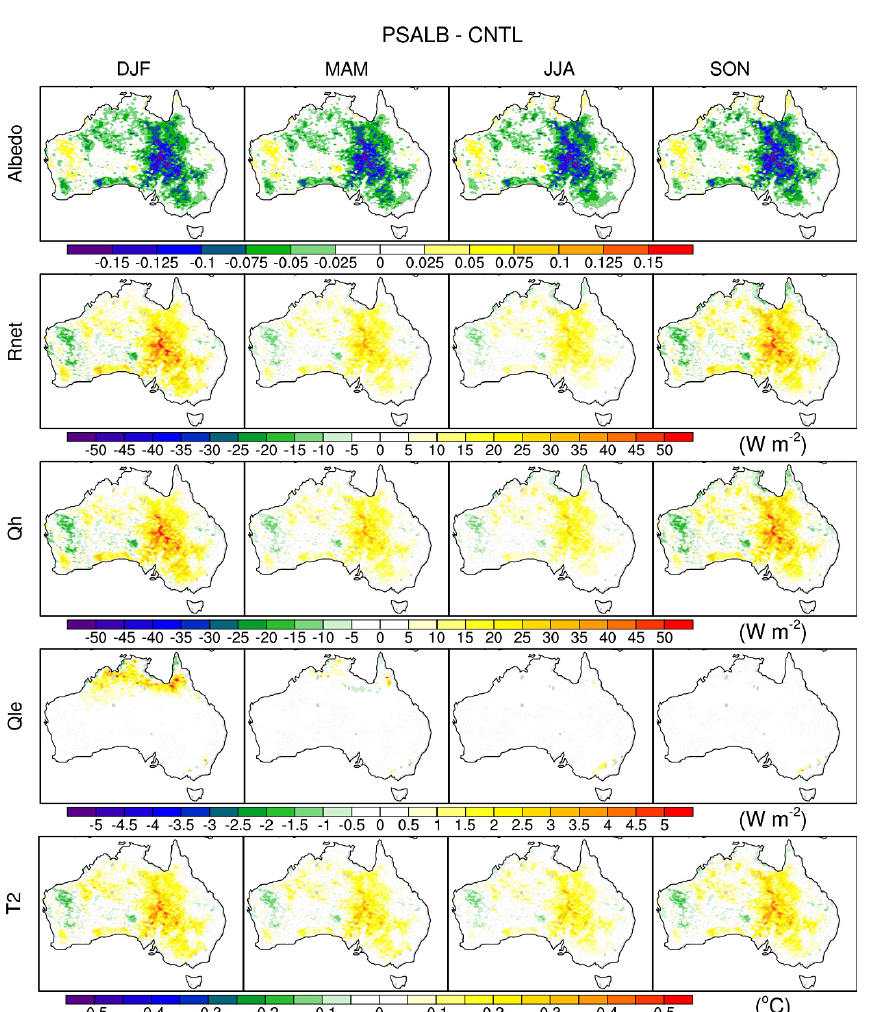
Figure 10. Seasonal differences in albedo, net radiation (Rnet), sensible heat (Qh), latent heat (Qle) flux, and screen-level-derived temperature (T2) between the PSALB and CNTL experiments